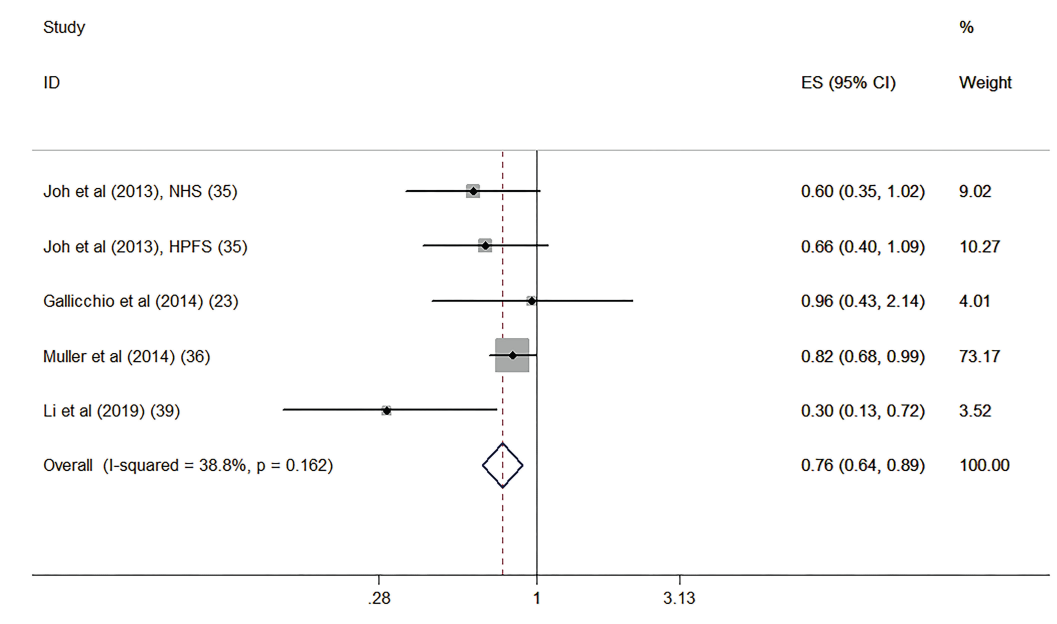
Figure 2 - Forest plot for circulating vitamin D level and risk of renal cell carcinoma.